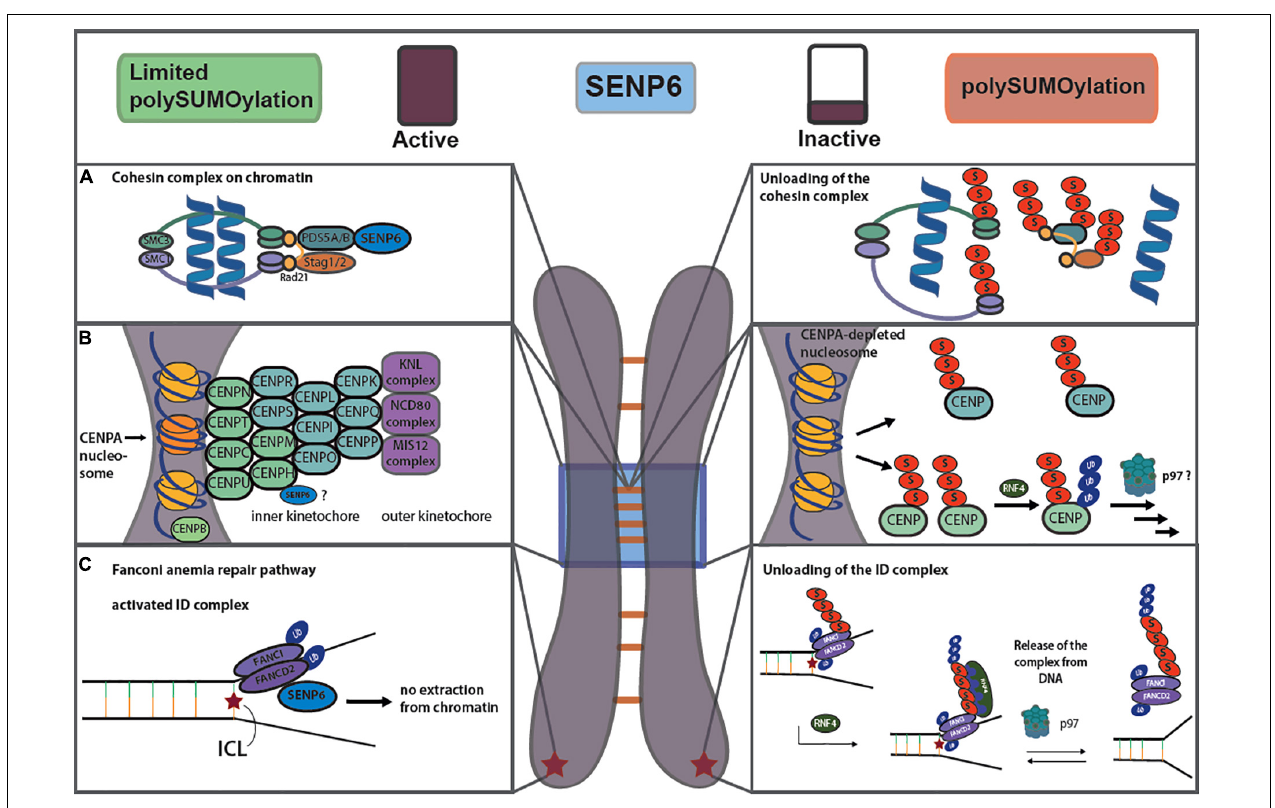
FIGURE 2 | Balancing SUMO chain formation controls chromatin residency of the cohesion complex (A) , the centromere network (B) and the FA repair pathway (C) . For details see